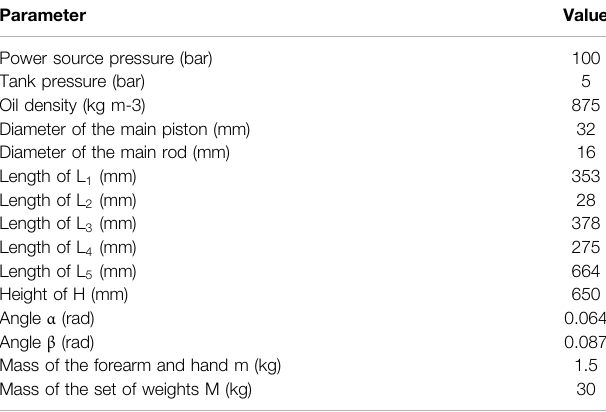
TABLE 2 | Paramenters of the experimental